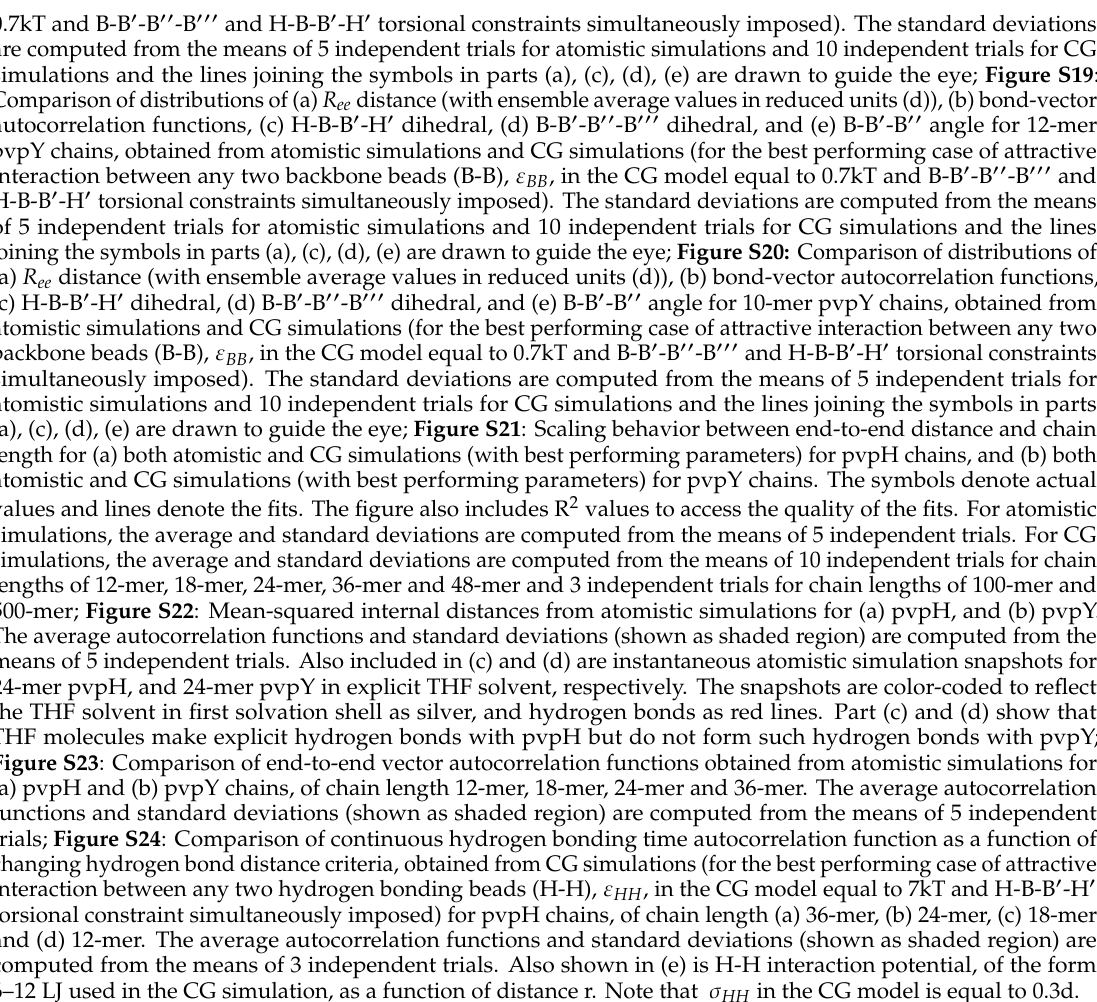
0.7kT and B-B (cid:48) -B (cid:48)(cid:48) -B (cid:48)(cid:48)(cid:48) and H-B-B (cid:48) -H (cid:48) torsional constraints simultaneously imposed). The standard deviations are computed from the means of 5 independent trials for atomistic simulations and 10 independent trials for CG simulations and the lines joining the symbols in parts (a), (c), (d), (e) are drawn to guide the eye; Figure S19 : Comparison of distributions of (a) R ee distance (with ensemble average values in reduced units (d)), (b) bond-vector autocorrelation functions, (c) H-B-B (cid:48) -H (cid:48) dihedral, (d) B-B (cid:48) -B (cid:48)(cid:48) -B (cid:48)(cid:48)(cid:48) dihedral, and (e) B-B (cid:48) -B (cid:48)(cid:48) angle for 12-mer pvpY chains, obtained from atomistic simulations and CG simulations (for the best performing case of attractive interaction between any two backbone beads (B-B), ε BB , in the CG model equal to 0.7kT and B-B (cid:48) -B (cid:48)(cid:48) -B (cid:48)(cid:48)(cid:48) and H-B-B (cid:48) -H (cid:48) torsional constraints simultaneously imposed). The standard deviations are computed from the means of 5 independent trials for atomistic simulations and 10 independent trials for CG simulations and the lines joining the symbols in parts (a), (c), (d), (e) are drawn to guide the eye; Figure S20: Comparison of distributions of atomistic simulations and CG simulations (for the best performing case of attractive interaction between any two backbone beads (B-B), ε BB , in the CG model equal to 0.7kT and B-B (cid:48) -B (cid:48)(cid:48) -B (cid:48)(cid:48)(cid:48) and H-B-B (cid:48) -H (cid:48) torsional constraints simultaneously imposed). The standard deviations are computed from the means of 5 independent trials for atomistic simulations and 10 independent trials for CG simulations and the lines joining the symbols in parts (a), (c), (d), (e) are drawn to guide the eye; Figure S21 : Scaling behavior between end-to-end distance and chain length for (a) both atomistic and CG simulations (with best performing parameters) for pvpH chains, and (b) both atomistic and CG simulations (with best performing parameters) for pvpY chains. The symbols denote actual values and lines denote the fits. The figure also includes R 2 values to access the quality of the fits. For atomistic simulations, the average and standard deviations are computed from the means of 5 independent trials. For CG simulations, the average and standard deviations are computed from the means of 10 independent trials for chain lengths of 12-mer, 18-mer, 24-mer, 36-mer and 48-mer and 3 independent trials for chain lengths of 100-mer and 500-mer; Figure S22 : Mean-squared internal distances from atomistic simulations for (a) pvpH, and (b) pvpY. The average autocorrelation functions and standard deviations (shown as shaded region) are computed from the means of 5 independent trials. Also included in (c) and (d) are instantaneous atomistic simulation snapshots for 24-mer pvpH, and 24-mer pvpY in explicit THF solvent, respectively. The snapshots are color-coded to reflect the THF solvent in first solvation shell as silver, and hydrogen bonds as red lines. Part (c) and (d) show that THF molecules make explicit hydrogen bonds with pvpH but do not form such hydrogen bonds with pvpY; Figure S23 : Comparison of end-to-end vector autocorrelation functions obtained from atomistic simulations for (a) pvpH and (b) pvpY chains, of chain length 12-mer, 18-mer, 24-mer and 36-mer. The average autocorrelation functions and standard deviations (shown as shaded region) are computed from the means of 5 independent trials; Figure S24 : Comparison of continuous hydrogen bonding time autocorrelation function as a function of changing hydrogen bond distance criteria, obtained from CG simulations (for the best performing case of attractive interaction between any two hydrogen bonding beads (H-H), ε HH , in the CG model equal to 7kT and H-B-B (cid:48) -H (cid:48) torsional constraint simultaneously imposed) for pvpH chains, of chain length (a) 36-mer, (b) 24-mer, (c) 18-mer and (d) 12-mer. The average autocorrelation functions and standard deviations (shown as shaded region) are computed from the means of 3 independent trials. Also shown in (e) is H-H interaction potential, of the form 6–12 LJ used in the CG simulation, as a function of distance r. Note that σ HH in the CG model is equal to